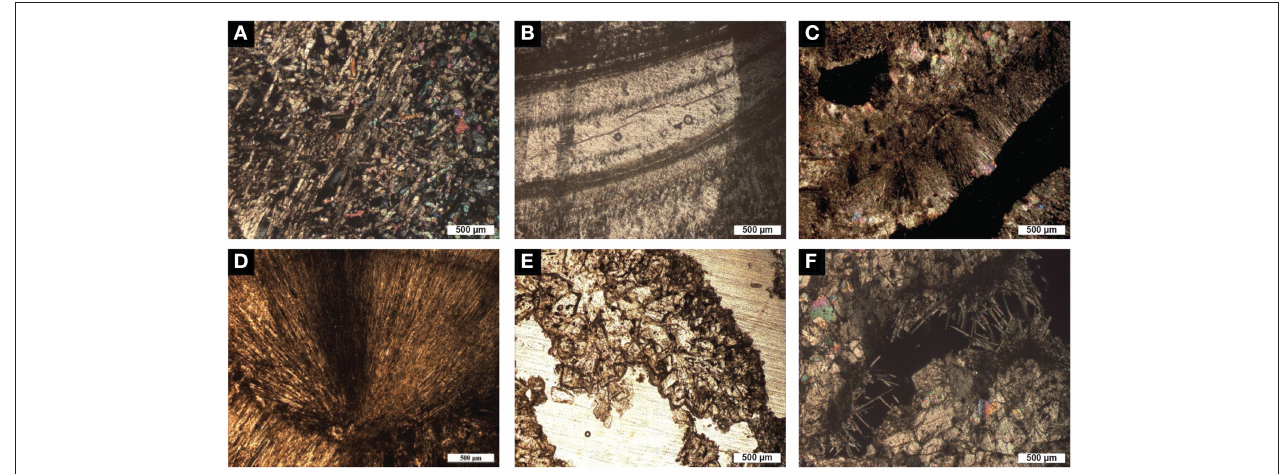
FIGURE 2 | Optical microscope images of the different units forming the mushroom speleothem. (A) The stalagmite unit, which is composed of calcite crystals, is locally characterized by a dendritic fabric showing a scaffold-like arrangement and a high porosity (NX). (B) Microcrystalline fabric showing the laminae (likely annual growth) that characterize the inner stalagmite (NX). (C) Calcite raft composed of sparry-calcite crystals surrounded by aragonite needles (NX). (D) Aragonite crystals that constitute the cave cloud unit with acicular fabric (NX). (E) Sparry-calcite aggregates that constitute the mushroom cap (N//). (F) Fenestrae within the mushroom cap filled with rhombohedral calcite crystals and pyramidal fibers of calcite